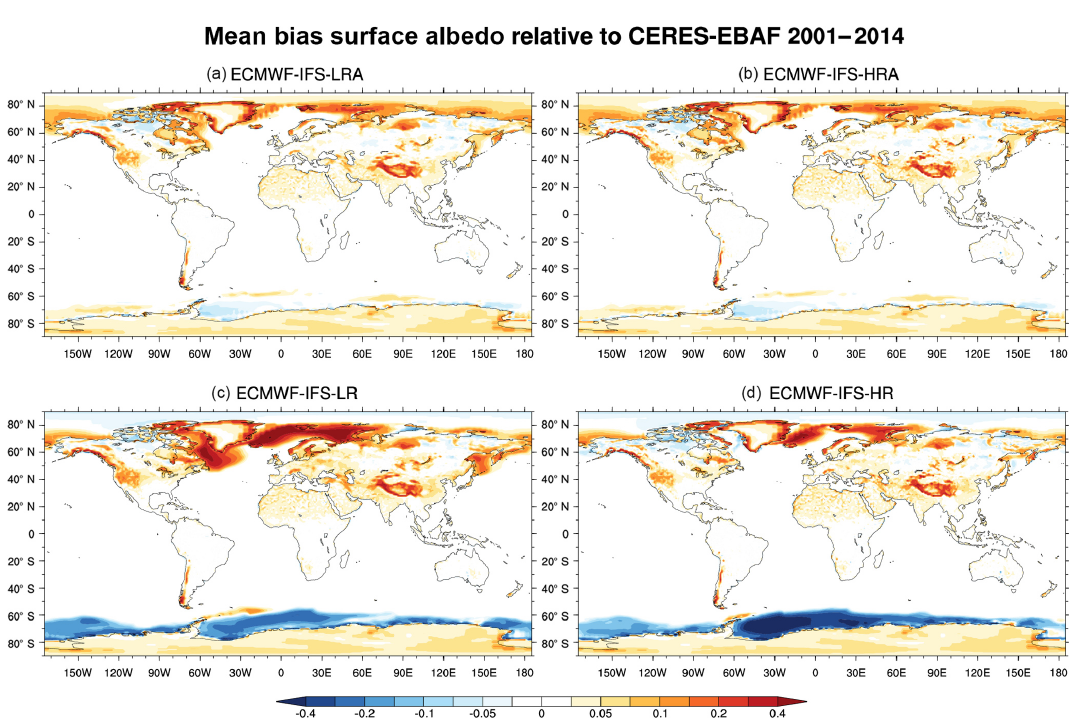
Figure 7. As Fig. 5 but for long-wave radiation fluxes.